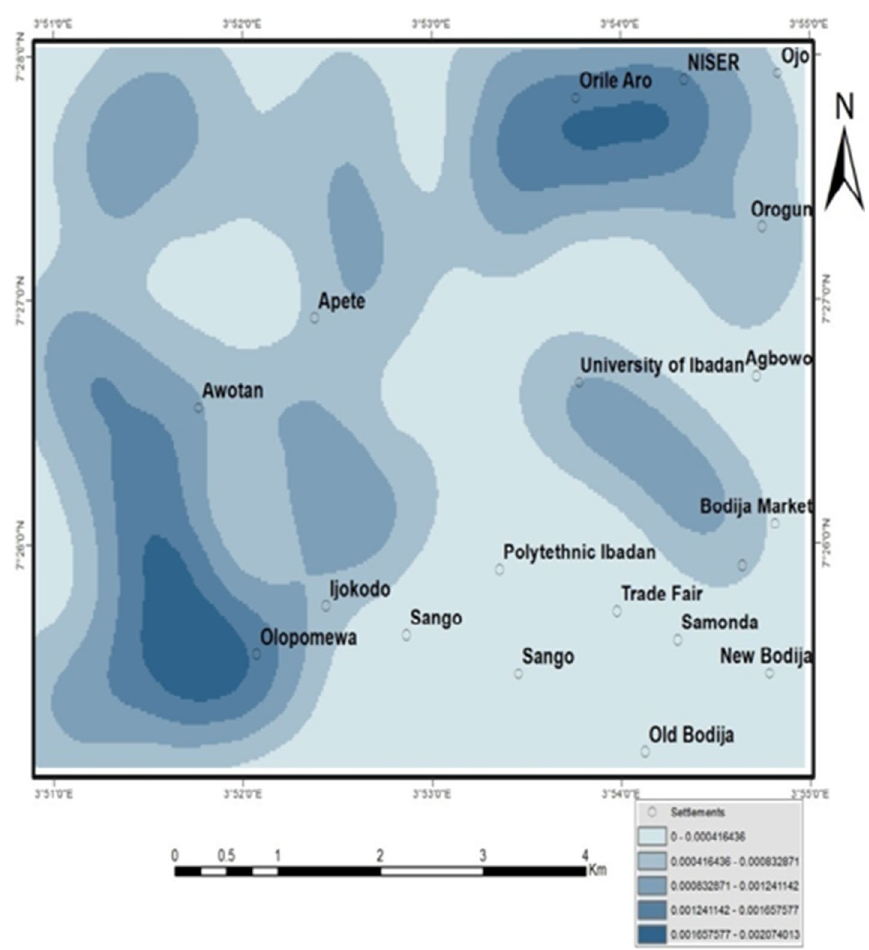
Fig. 6 Lineament density map of the study